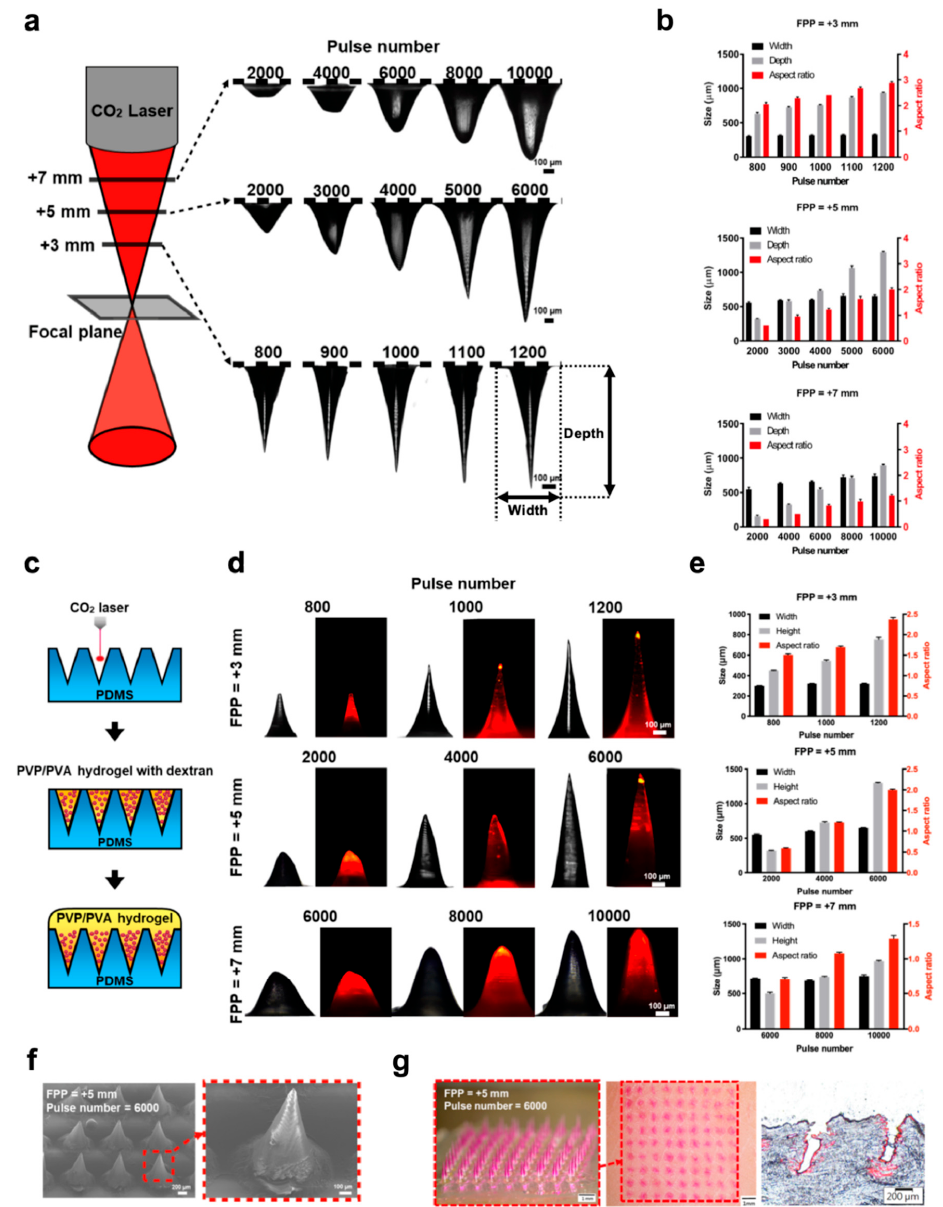
/ polyvinyl alcohol (PVP / PVA) MN arrays using a Figure 2. Fabrication of polyvinylpyrrolidone/polyvinyl alcohol (PVP/PVA) MN arrays using a laser- Figure 2. Fabrication of polyvinylpyrrolidone laser-ablated PDMS mold. ( a ) Schematic diagram of the laser-ablation process for creating PDMS molds with various CO 2 laser pulse numbers in focal plane positions (FPPs). ( b ) Evaluation of